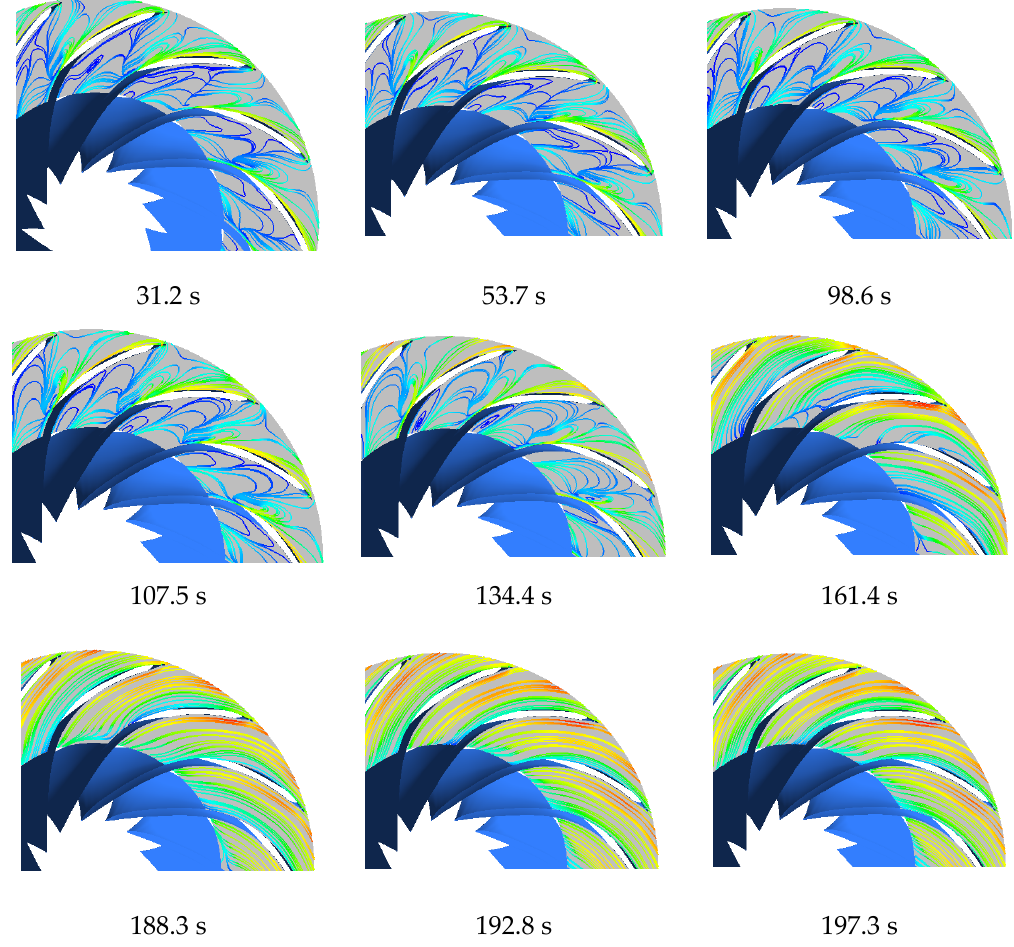
Figure 9. The internal flow changes in the runner during turbine start-up.